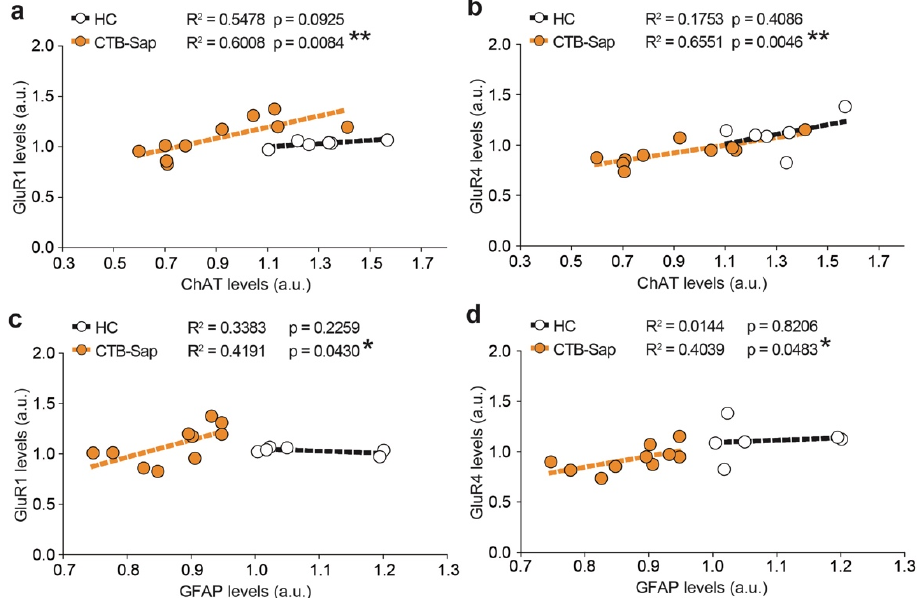
Figure 8. Significant correlations between spinal MNs and astrocytes and AMPA subunits, GluR1 and GluR4. ( a , b ) Linear regression analysis of GluR1 ( a ) or GluR4 ( b ) levels and ChAT levels; ** p -value < 0.01. ( c , d ) Linear regression analysis of GluR1 ( c ) or GluR4 ( d ) levels and GFAP levels; * p -value < 0.05.